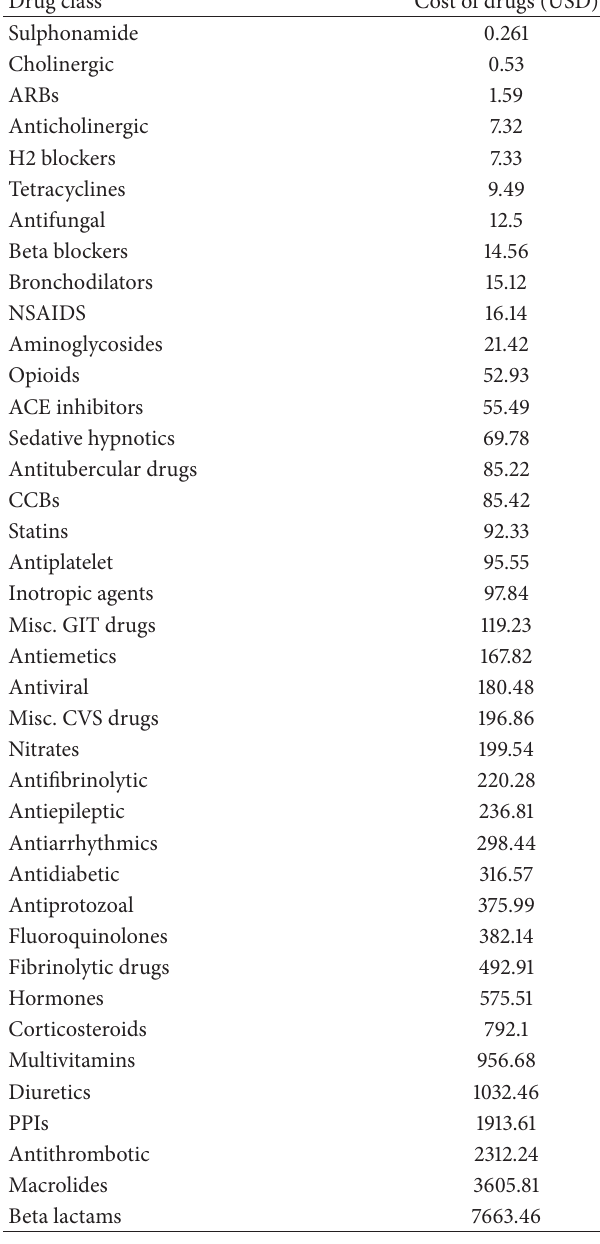
Table 3: Cost of various drug classes.